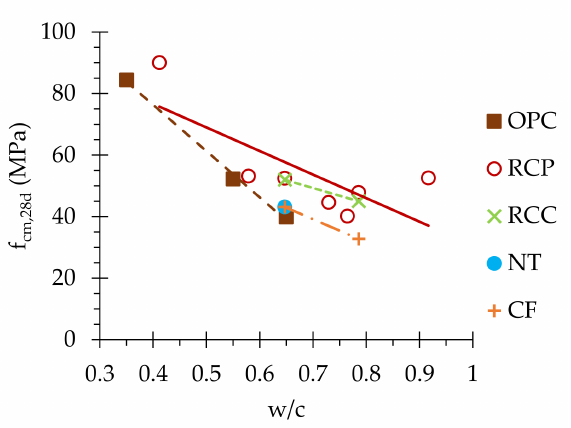
Figure 10. Compressive strength at 28 days, f cm ,28 d , of the produced concretes as a function of the